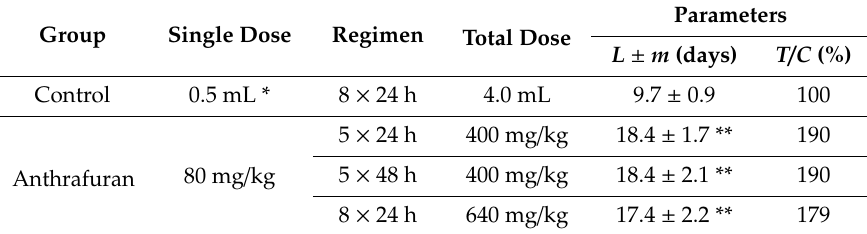
Table 2. Oral administration e ffi cacy of anthrafuran on i.p. P388 using di ff erent